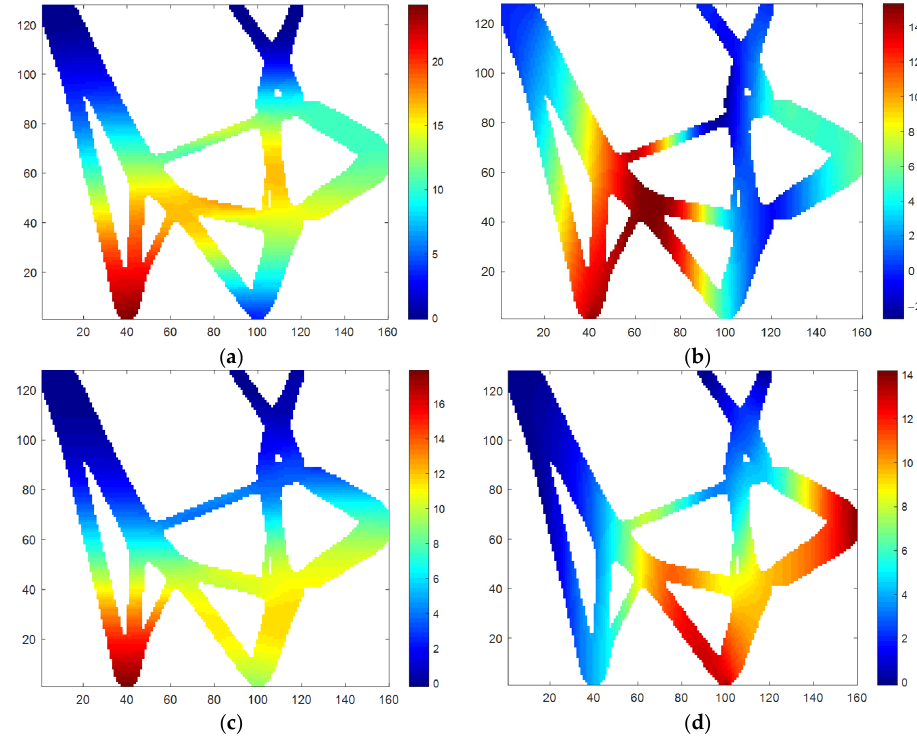
Figure 7. Obtained displacement distributions using Equation (19): ( a ) horizontal and ( b ) vertical displacement results generated by F I 1 , ( c ) horizontal and ( b ) vertical displacement results generated by F I 2 .